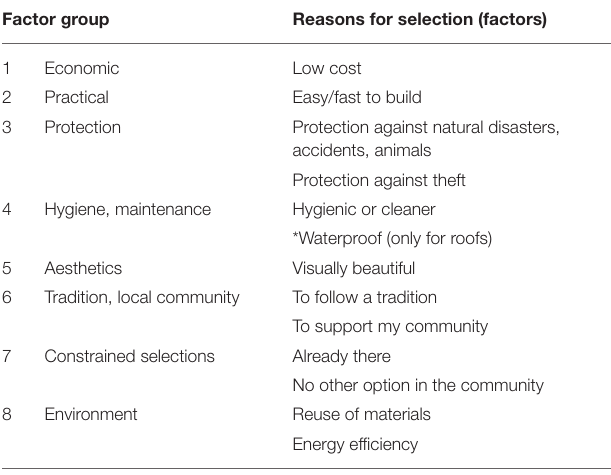
TABLE 1 | Principal reasons hypothesised in the selection of wall and roof